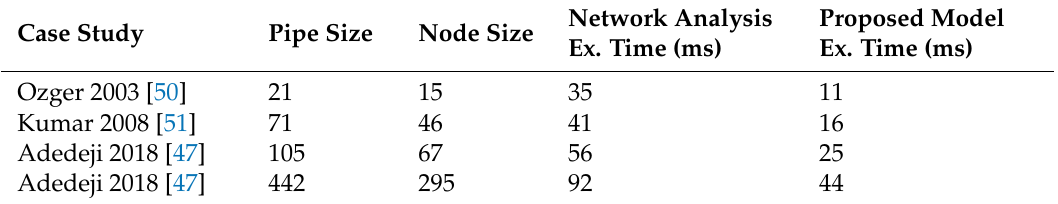
Table 9. Comparison of Computational time for Hydraulic Analysis and Proposed